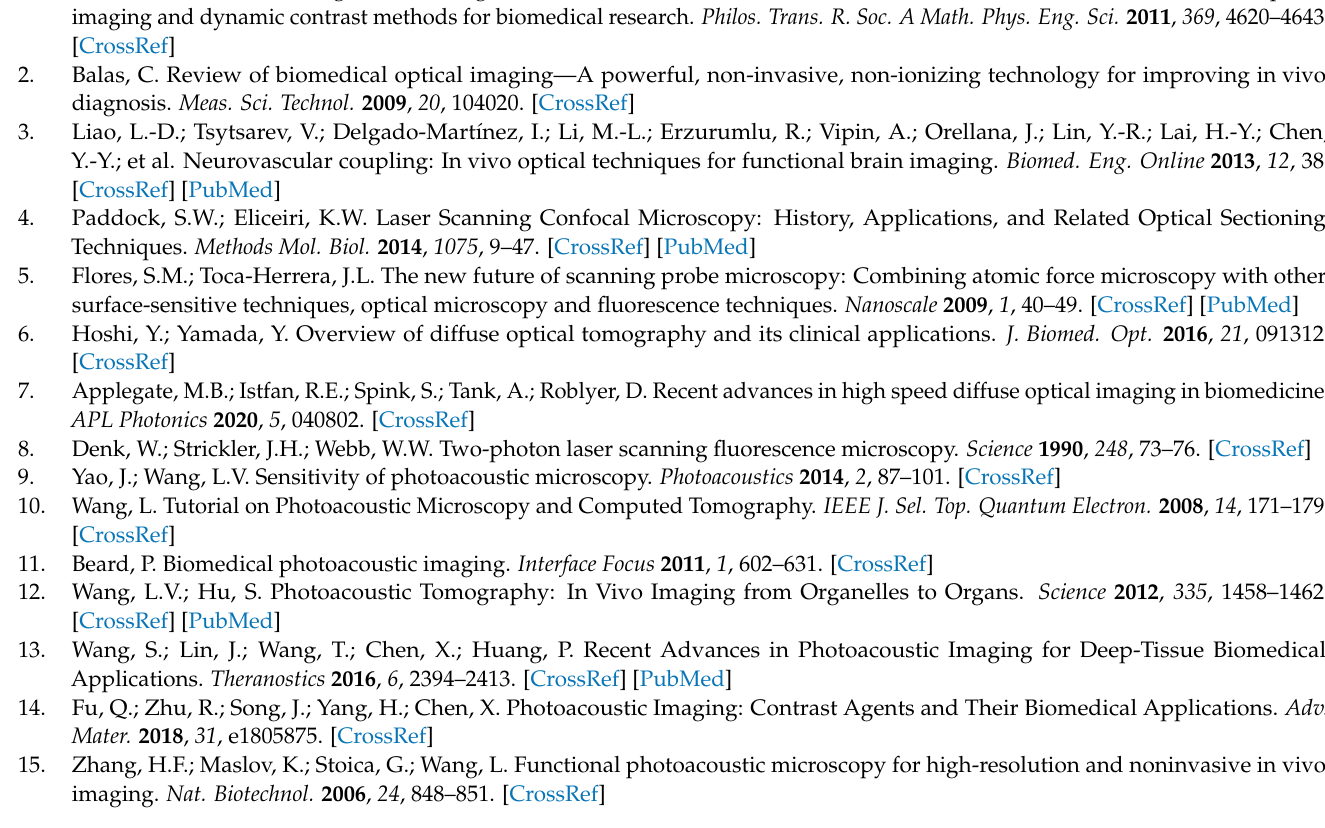
for Figure 10, Video S5 for Figure 11, and Video S6 for Figure